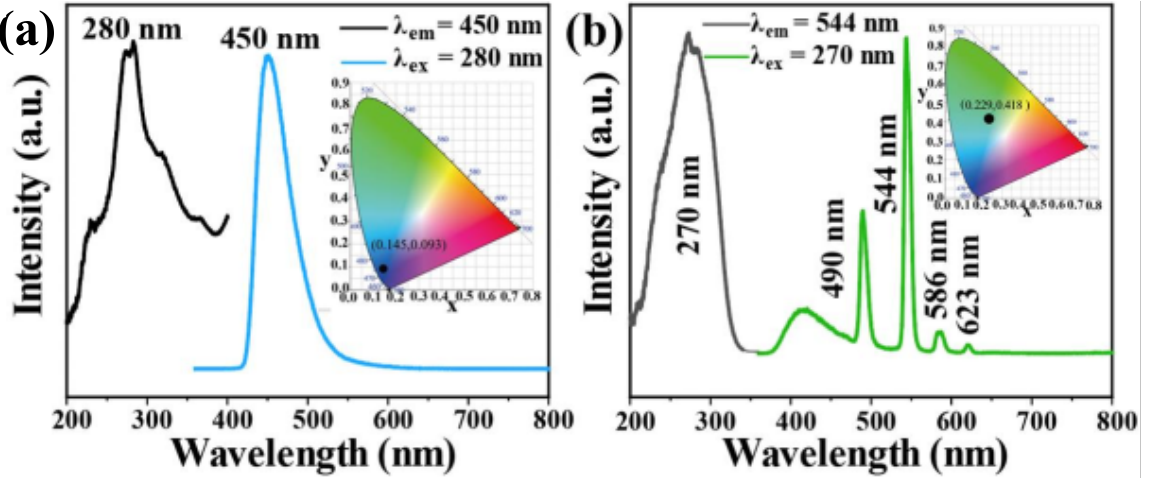
Figure 3. ( a ) Room temperature excitation and emission spectra of C460 and ( b ) Tb-UiO-66-(COOH) 2 . To prepare the dual-emission material C460@Tb-UiO-66-(COOH) 2 , different concen- Figure 4a. It is found that the samples prepared at 0.01 mol · L − 1 C460 show the characteris-